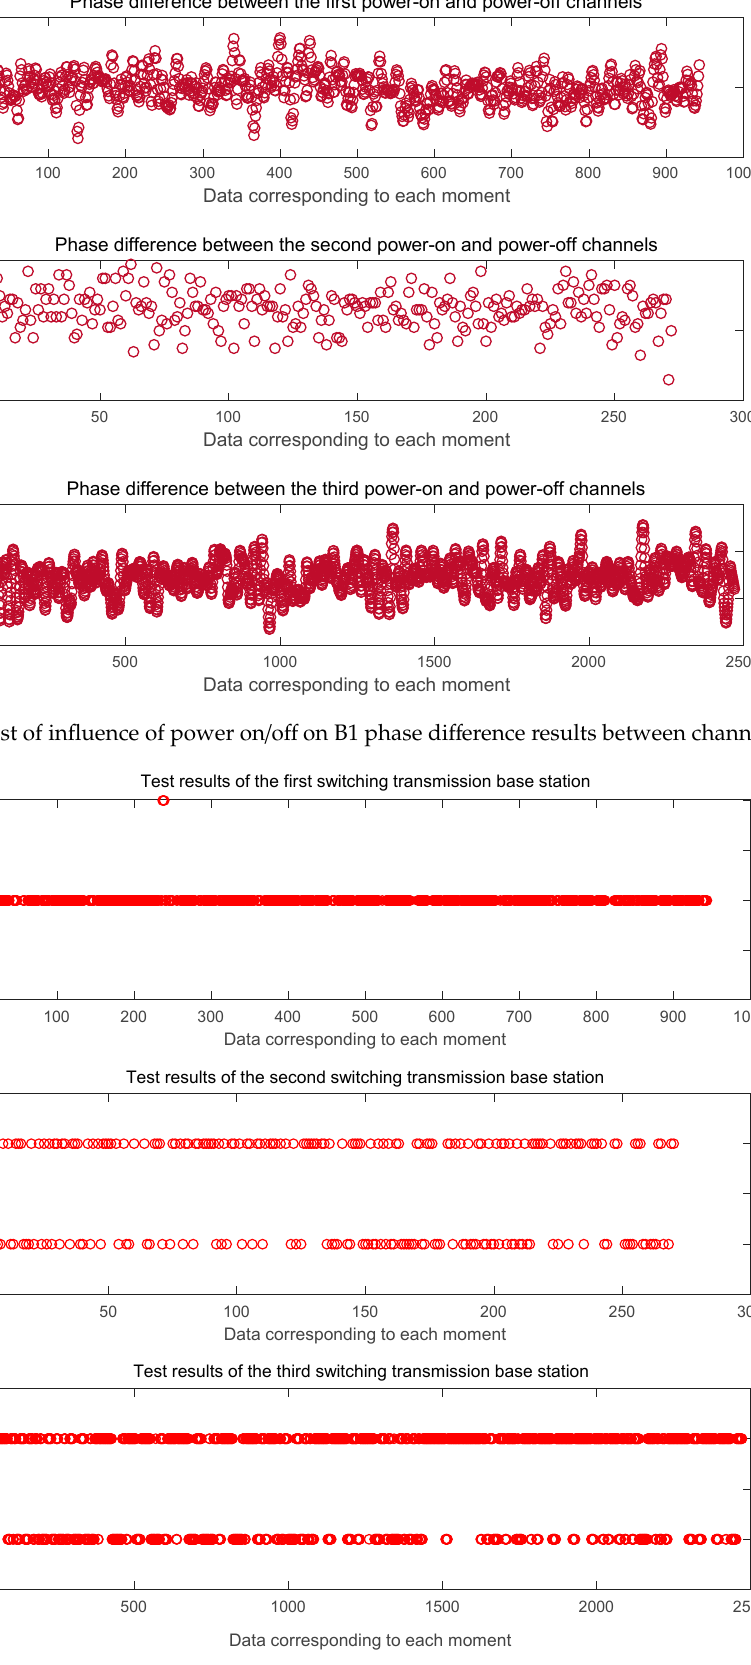
Figure 6. The distance based on the phase di ff erence is estimated by the whole number of wavelengths.